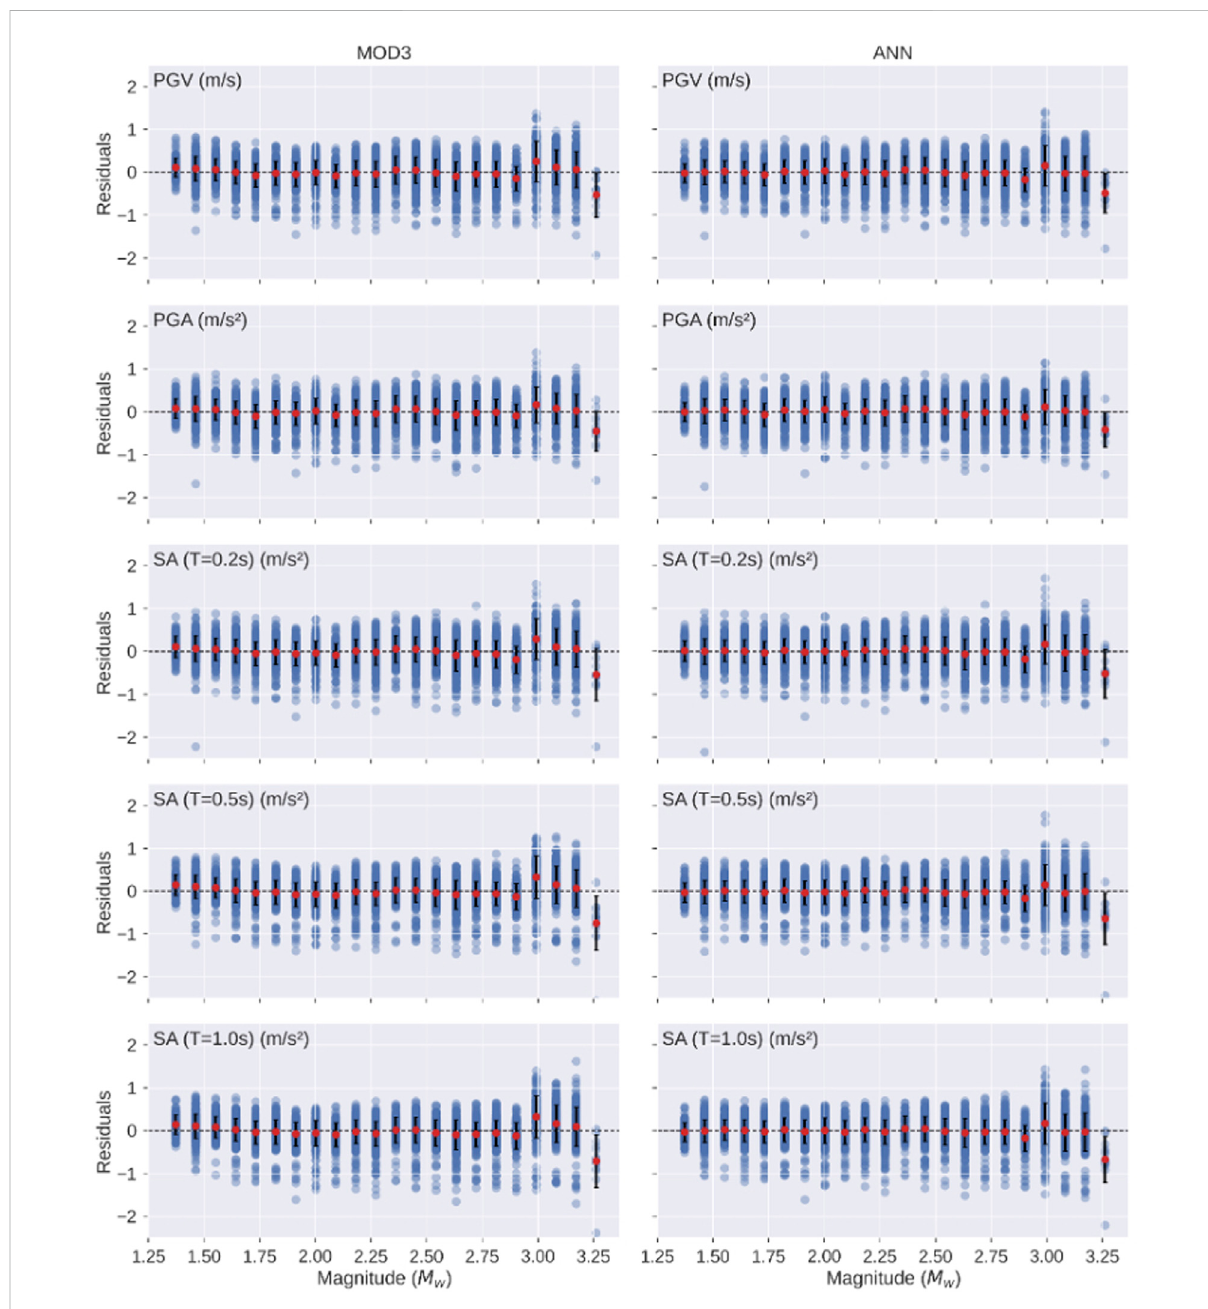
FIGURE 6 Residualplotswithbinnedmeans(reddots)andstandarddeviation(verticallines)relativetothemagnitudeforthemodelsMOD3andANN.The dashed line is present to mark the zero-residual